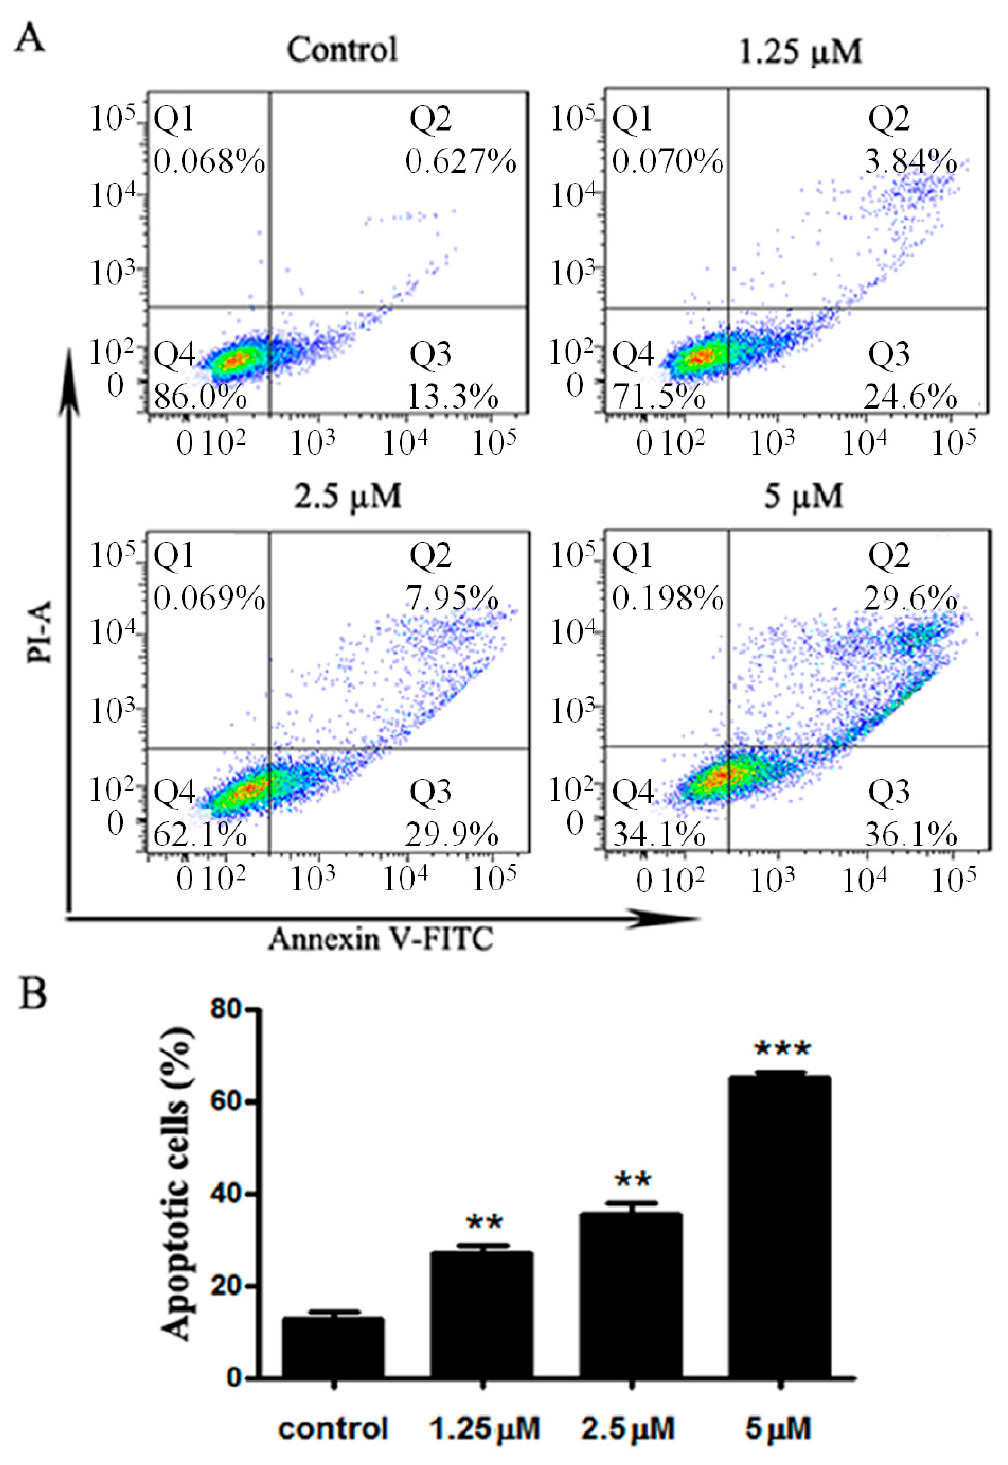
Figure 3. Flow cytometry analysis of MG63 cell apoptosis by double staining with annexin V-FITC and PI. Values are presented as mean ± SD of three independent experiments. ** p < 0.01 vs. normal control, *** p < 0.001 vs. normal control.